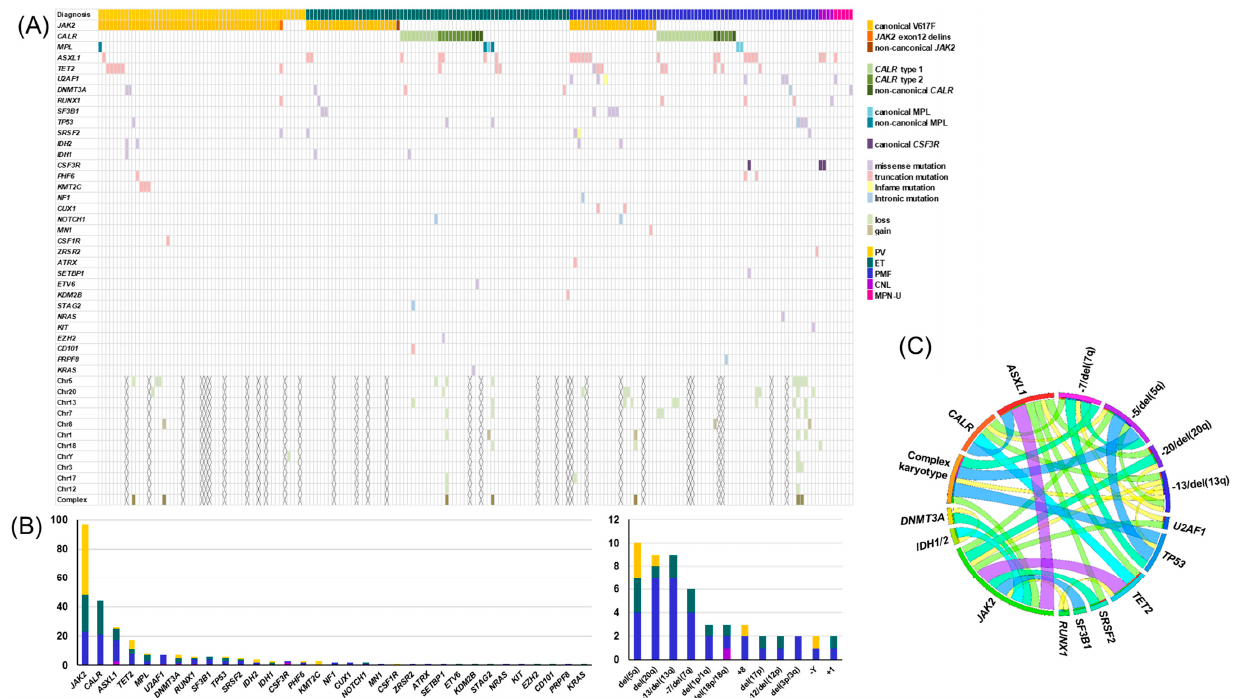
Figure 1. Genomic landscapes of 200 MPN patients. ( A ) The mosaic plot ( B ) The bar-charts of mutations and chromosomal abnormalities ( C ) The circos plot indicating recurrent co-occurrences of genetic aberrations by ribbon widths. PV: Polycythemia vera, ET: essential thrombocythemia, PMF: primary myelofibrosis, CNL: chronic neutrophilic leukemia, MPN-U: MPN-unclassifiable and MPN: myeloproliferative neoplasm.